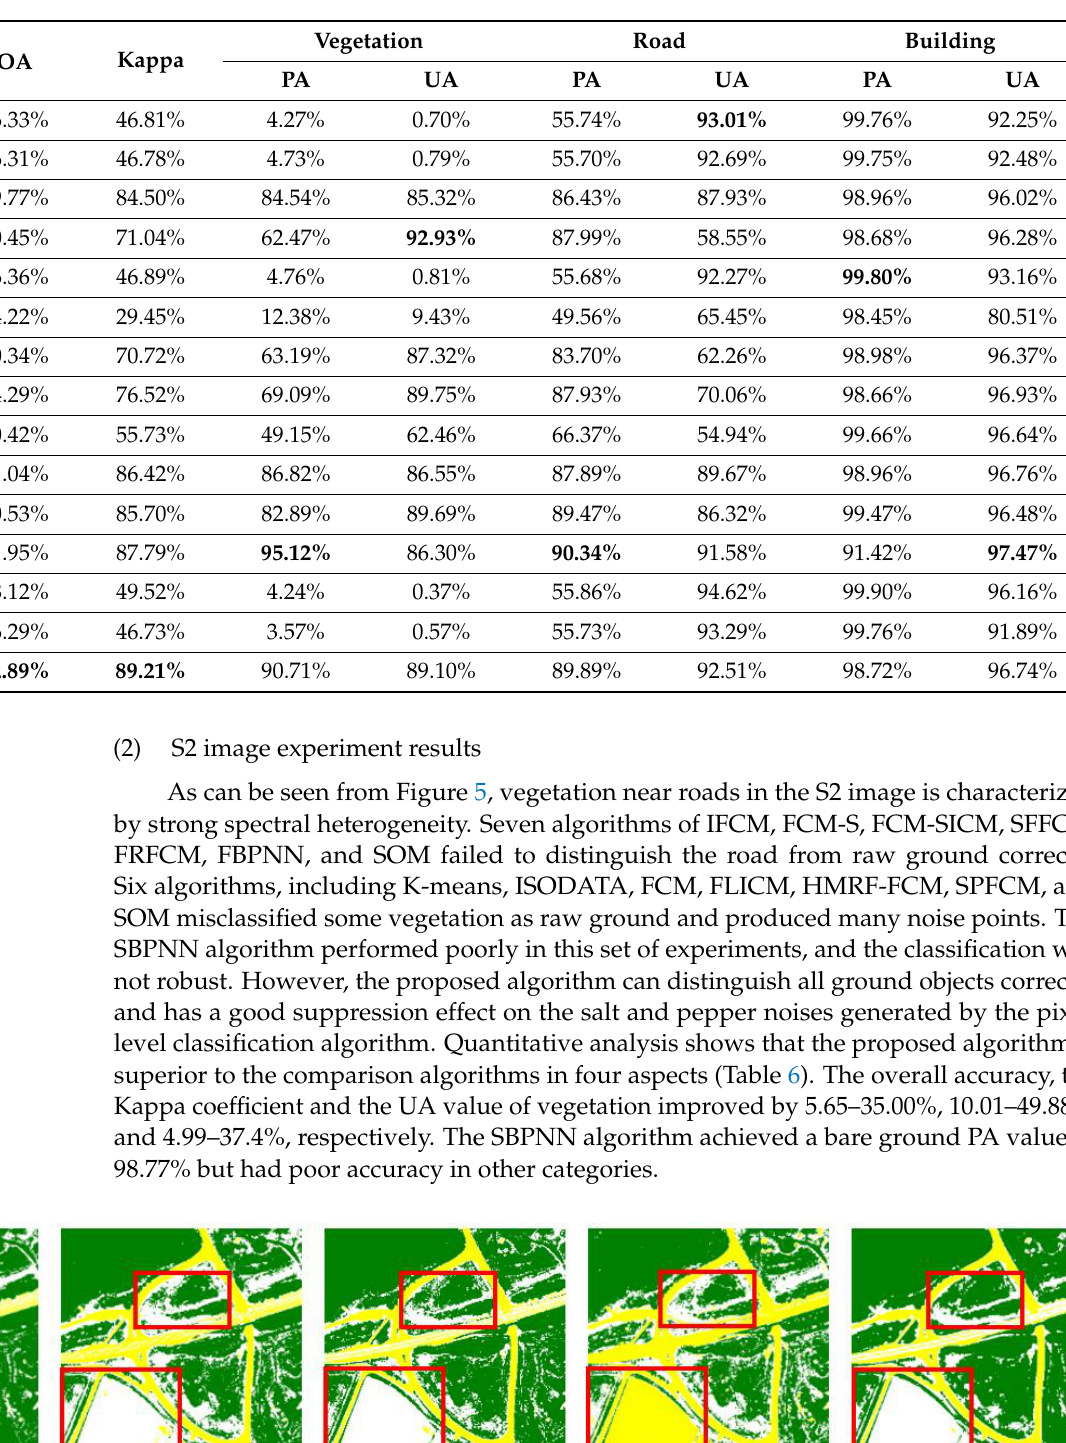
Table 5. Evaluation of S1 image classification results.